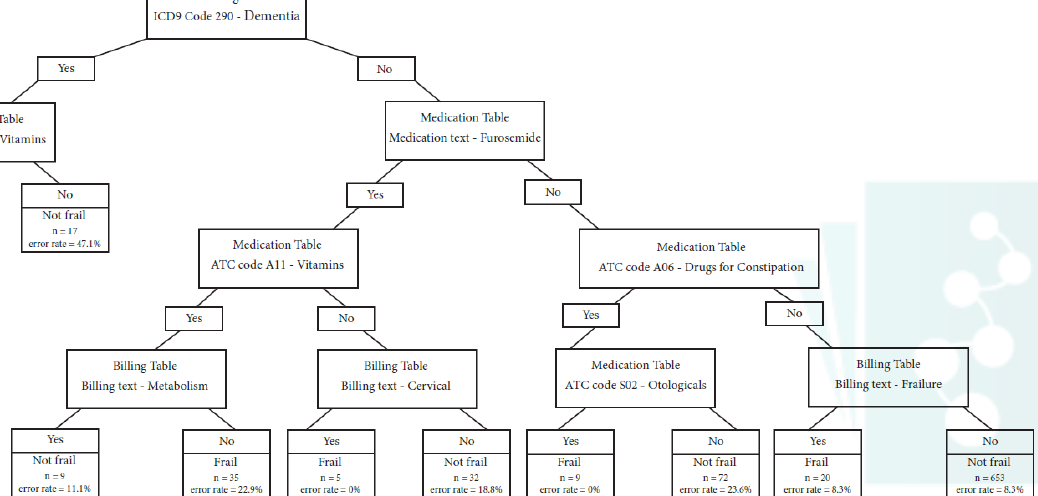
Figure 2: Final Decision